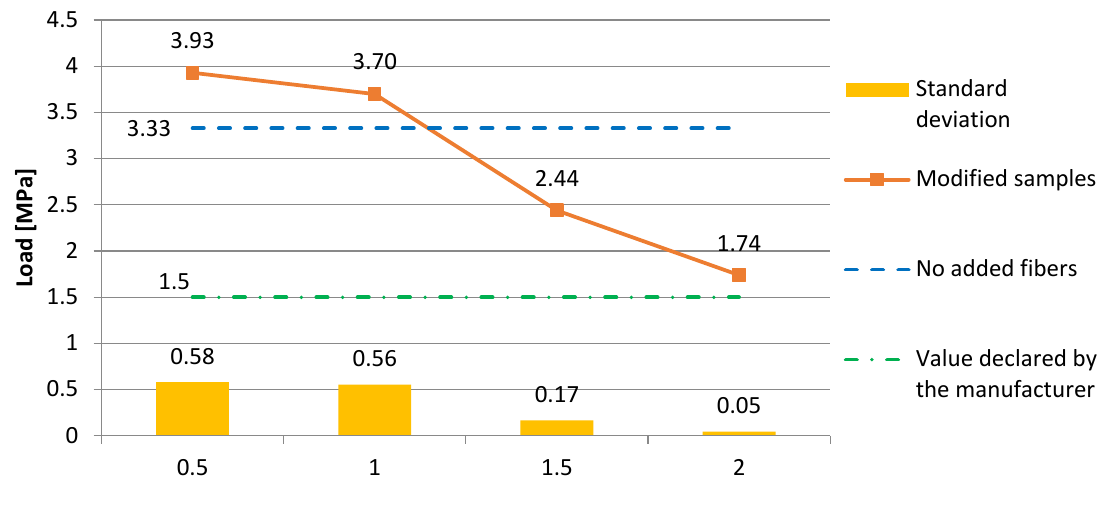
Figure 12. The dependence of the pull-off strength of the epoxy resin coating on the mortar substrate with regards to the amount of added fibers.